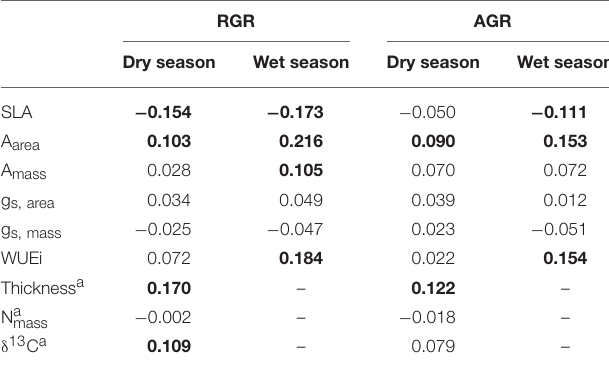
TABLE 4 | Semi-partial correlations between traits and residuals of RGR (relative growth rate) and AGR (absolute growth rate) obtained from mixed